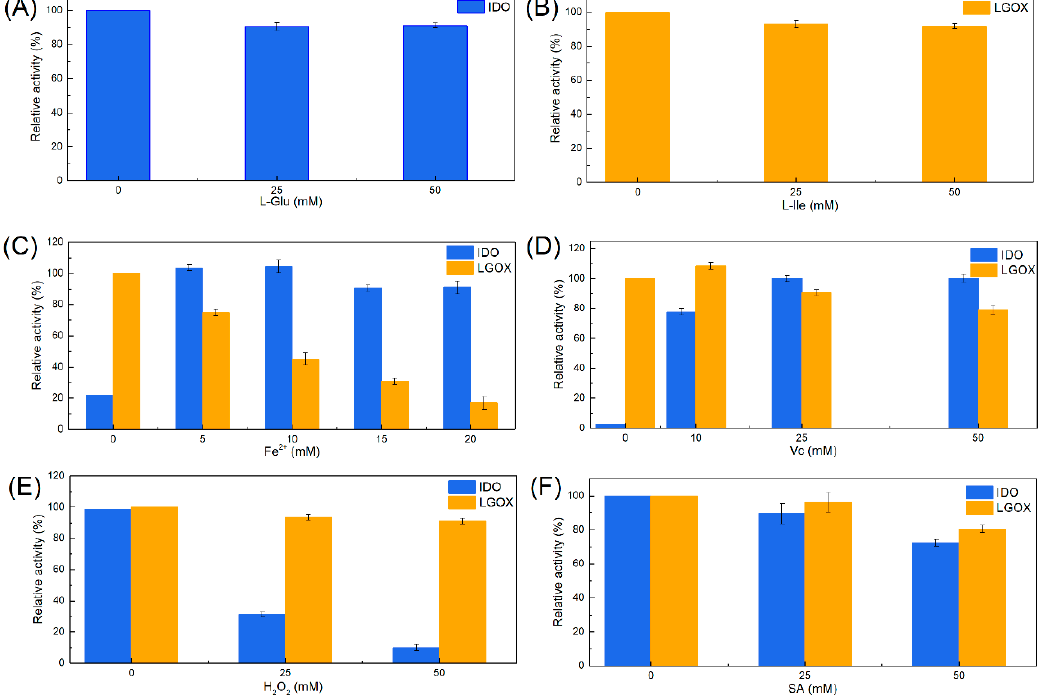
Figure 2. Effects of various reaction components on IDO (blue) and LGOX (orange) activity. IDO and LGOX activity levels were measured using various concentrations of ( A ) L -Glu, ( B ) L -Ile, ( C ) Fe 2+ , ( D ) Vc, ( E ) H 2 O 2 , and ( F ) SA. The specific activities of the enzymes under standard conditions (5.84 ± 0.07 U·mg -1 for IDO and 2.67 ± 0.09 U·mg -1 for LGOX) were designated as 100%, respectively.